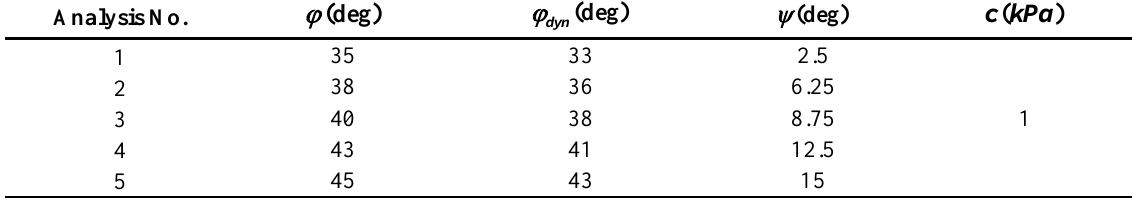
Table 2. Soil plastic parameters in different analyses Analysis